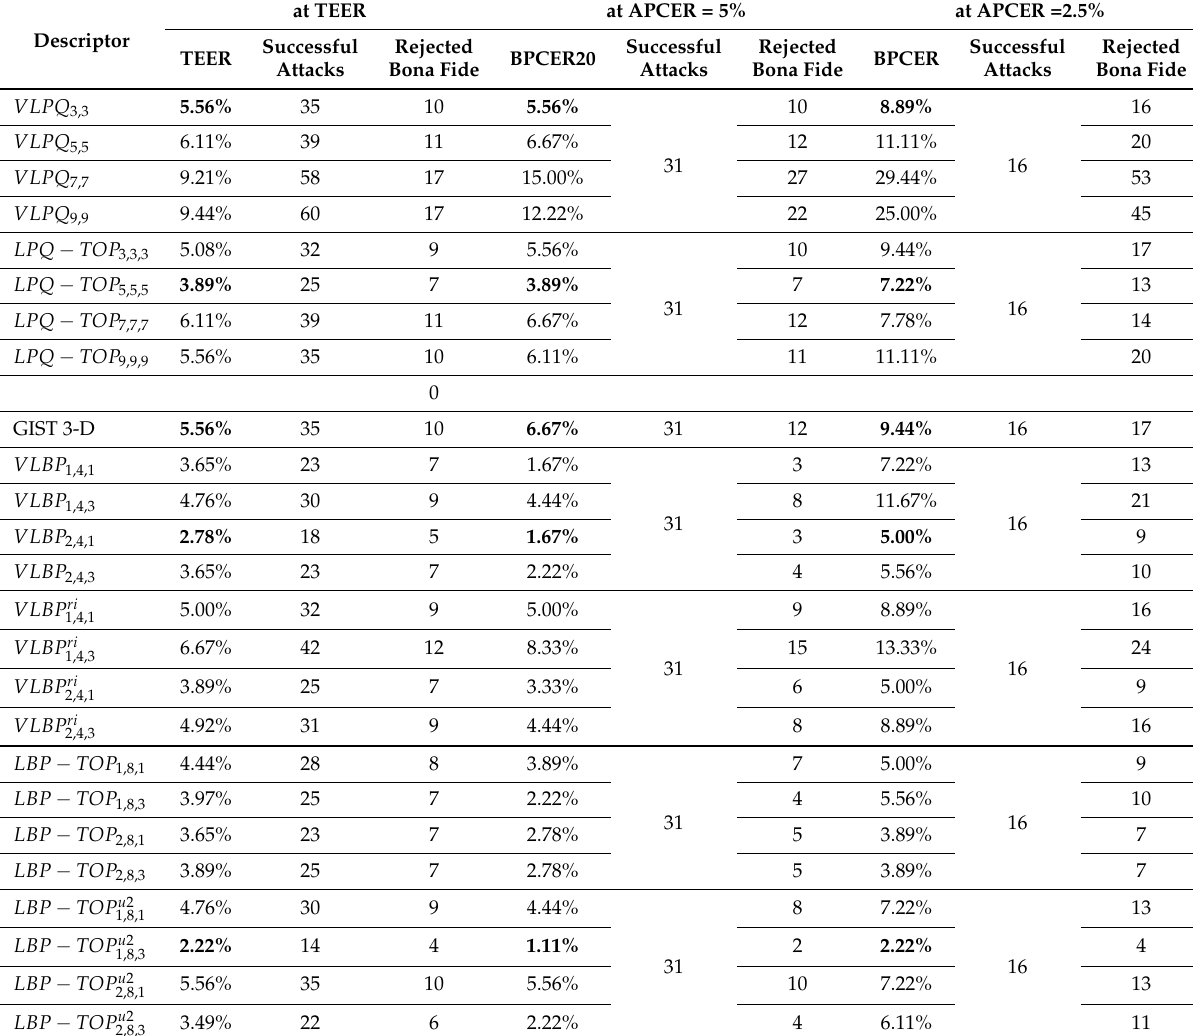
Table 5. PAD subsystem performance for the optical